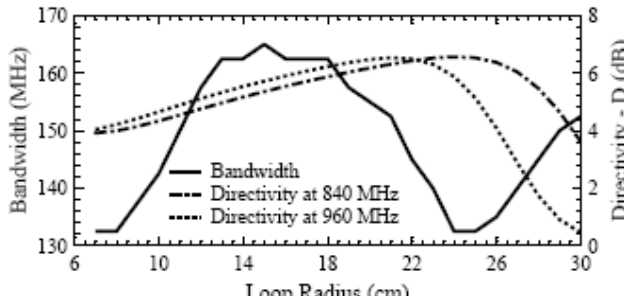
on the directivity and bandwidth +2